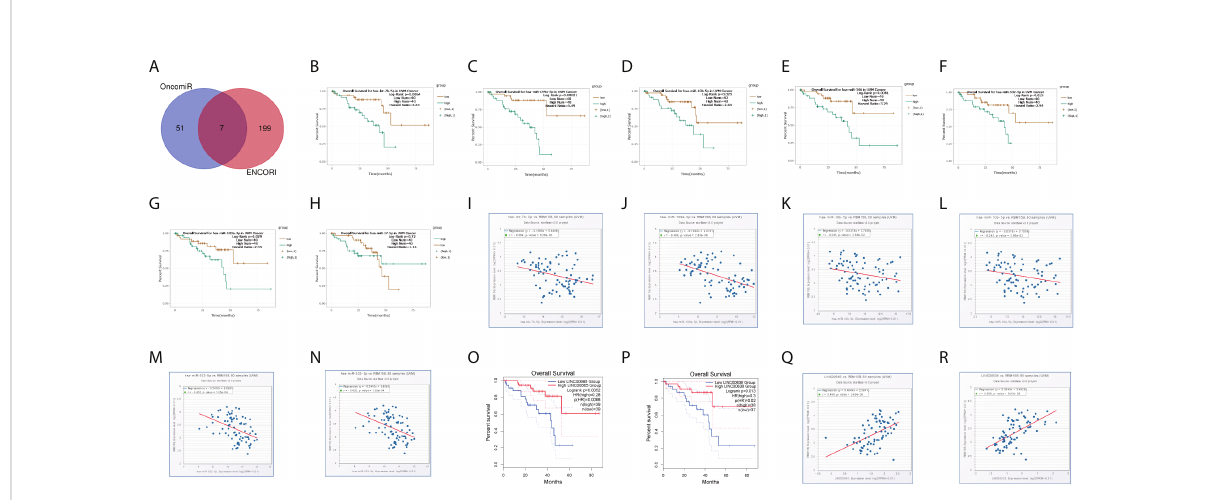
FIGURE 6 competing endogenous RNA network construction. (A) 7 potential target miRNAs were obtained from ENCORI and OncomiR databases. (B-H) Kaplan-Meier plots revealed the overall survival of 7 potential target miRNAs, including (B) hsa-let-7b-5p, (C) hsa-miR-199a-5p, (D) hsa-miR- 10b-5p, (E) hsa-miR-346, (F) hsa-miR-532-5p, (G) hsa-miR-103a-3p and (H) hsa-miR-17-5p. (I – N) among 7 potential target miRNAs, 6 miRNAs, (I) hsa-let-7b-5p, (J) hsa-miR-199a-5p, (K) hsa-miR-10b-5p, (L) hsa-miR-346, (M) hsa-miR-532-5p, and (N) hsa-miR-103a-3p signi fi cantly correlated the expression of RBM15B . Kaplan-Meier plots revealed the overall survival of 2 potential target lncRNAs, (O) LINC00665 and (P) LINC00638, predicted by ENCORI. 2 potential target lncRNAs, (Q) LINC00665 and (R) LINC00638, signi fi cantly correlated the expression of RBM15B